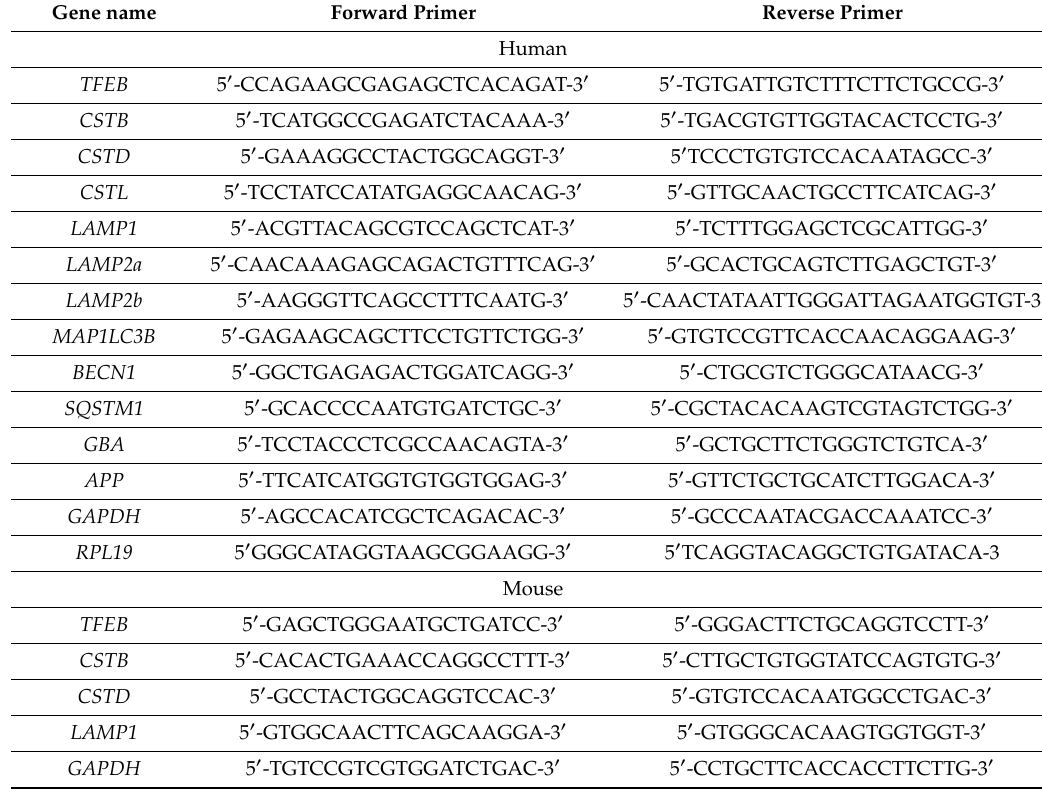
Table 1. List of primers used for quantitative